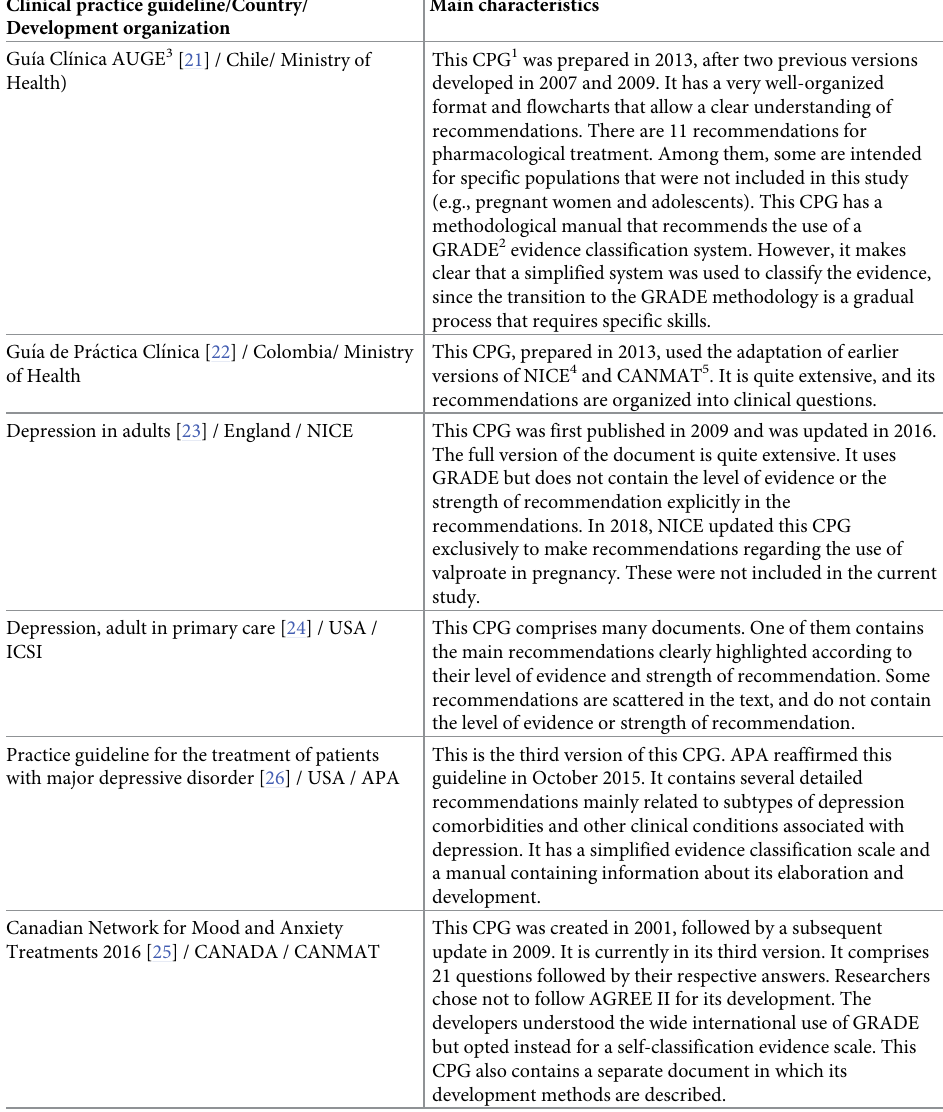
Table 1. Clinical practice guidelines for the pharmacological treatment of depression included for analysis of